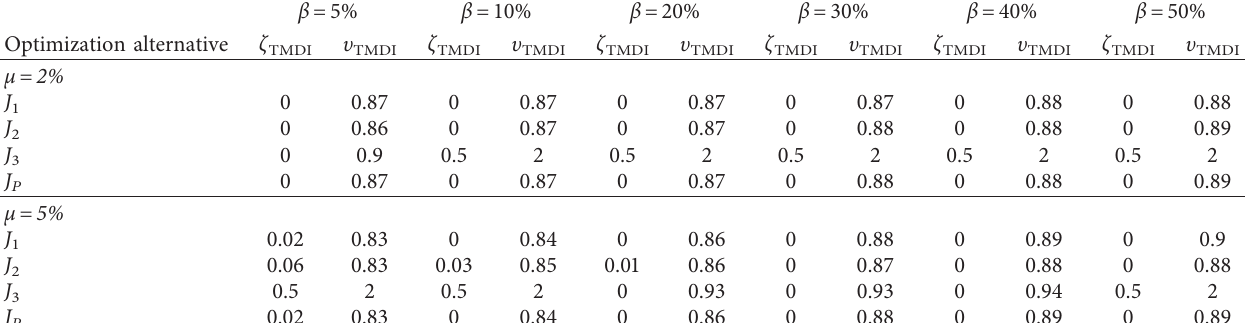
Table 10: TMDI optimization parameters for µ � 0.02 and µ � 0.05 for the structure subjected to the “ Algarrobo ” record.